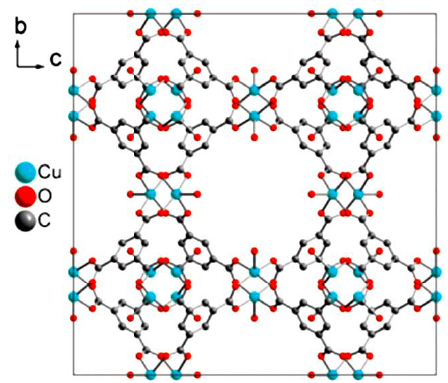
Figure 2. View of the packing of the cubic unit cell of HKUST-1. Reprinted with permission from reference [34]. Copyright 2017 Royal Society of Chemistry.